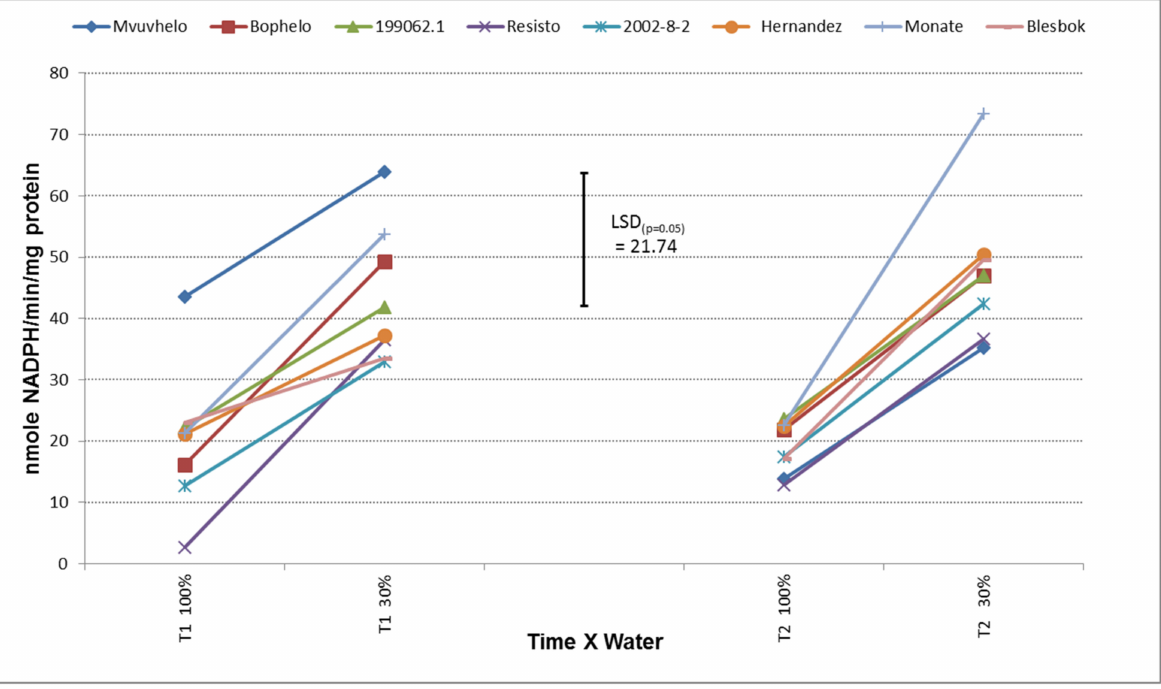
Figure 4. Glutathione reductase (GR) values in the leaves of eight sweet potato cultivars sub- jected to drought. LSD = 21.74; T1 = 60 days after planting; T2 = 120 days after planting. ( p = 0.05) 100% = control treatment; 30% = severe stress